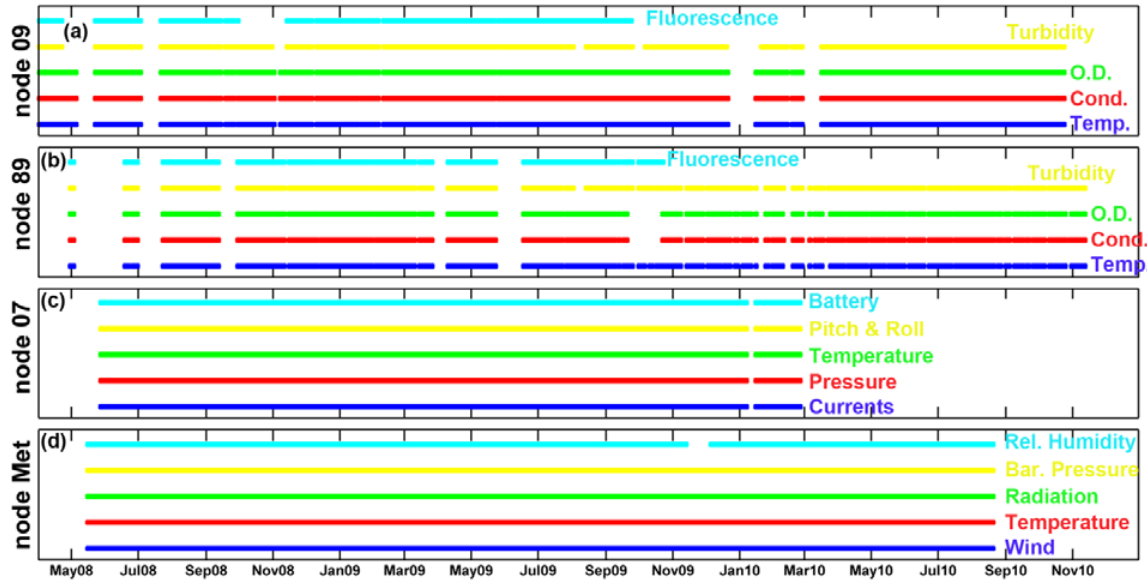
Figure 3 . Bar chart showing daily data availability at the different water nodes. Panels ( a,b ) represent the water quality nodes (09 and 89 respectively). Colors indicate the measured parameters: blue, red, green, yellow and cyan denote temperature, conductivity, dissolved oxygen, turbidity, and chlorophyll fluorescence respectively. Panel ( c ) corresponds to data availability from the water dynamic station (node 07) whereas panel ( d ) shows data availability from the meteorological node (Salmedina). More than 97% the complete bulk of data that could have been recorded was accessible during the study period. Gaps in the panels indicate no data availability for a particular time